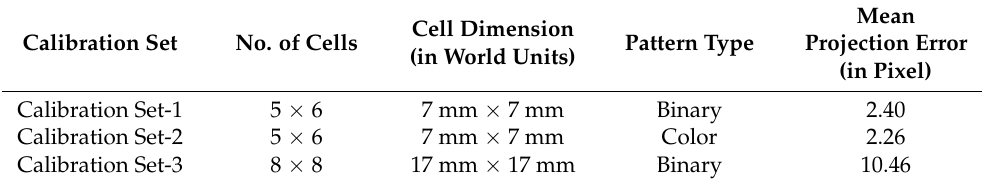
Cell Dimension (in World Units)